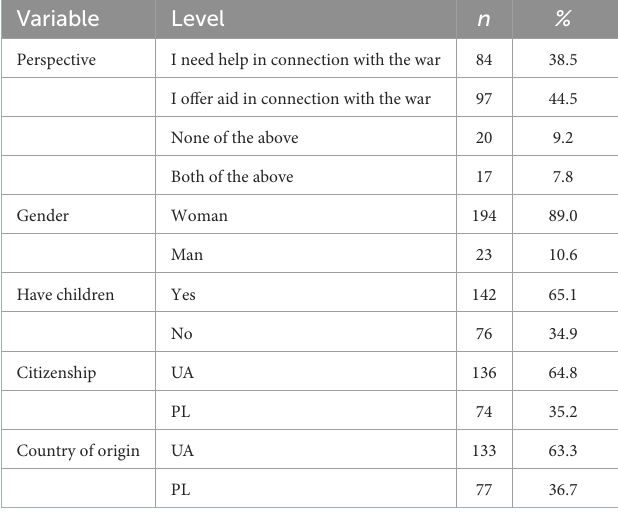
TABLE 2 Descriptive statistics of selected qualitative